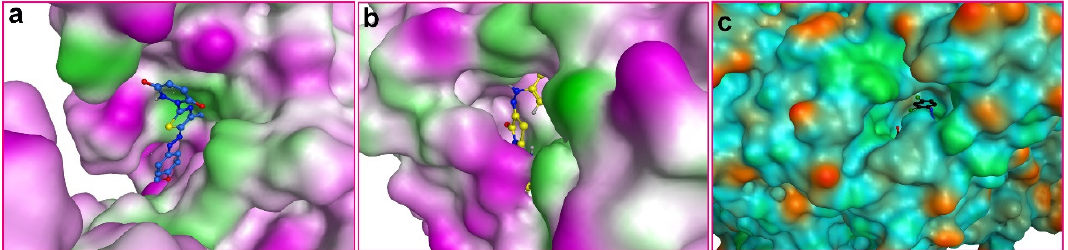
Figure 2. Structure of receptor molecules with the best fitting ligand molecules from the investigated set of ligands. ( a ) SAP2 of C. albicans / 5d , ( b ) FabI of S. aureus / 9c and ( c ) FabI of P. aeruginosa / 9d .